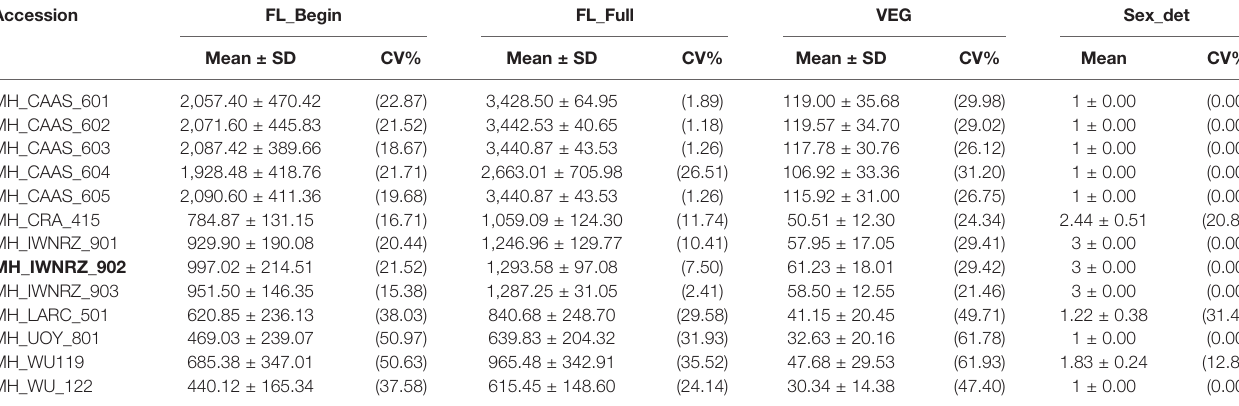
Phenotypic values indicate the averages across the three environments. Promising accessions across all three locations are highlighted in bold. See Table 3 for abbreviations. Sex_det stands for Sex